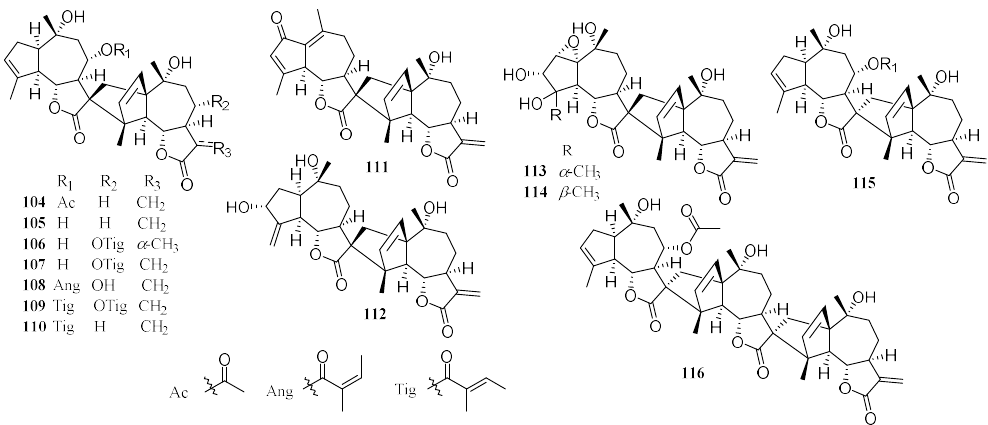
Figure 5. Disesquiterpenoids and a trisesquiterpenoid from the Chrysanthemum genus.